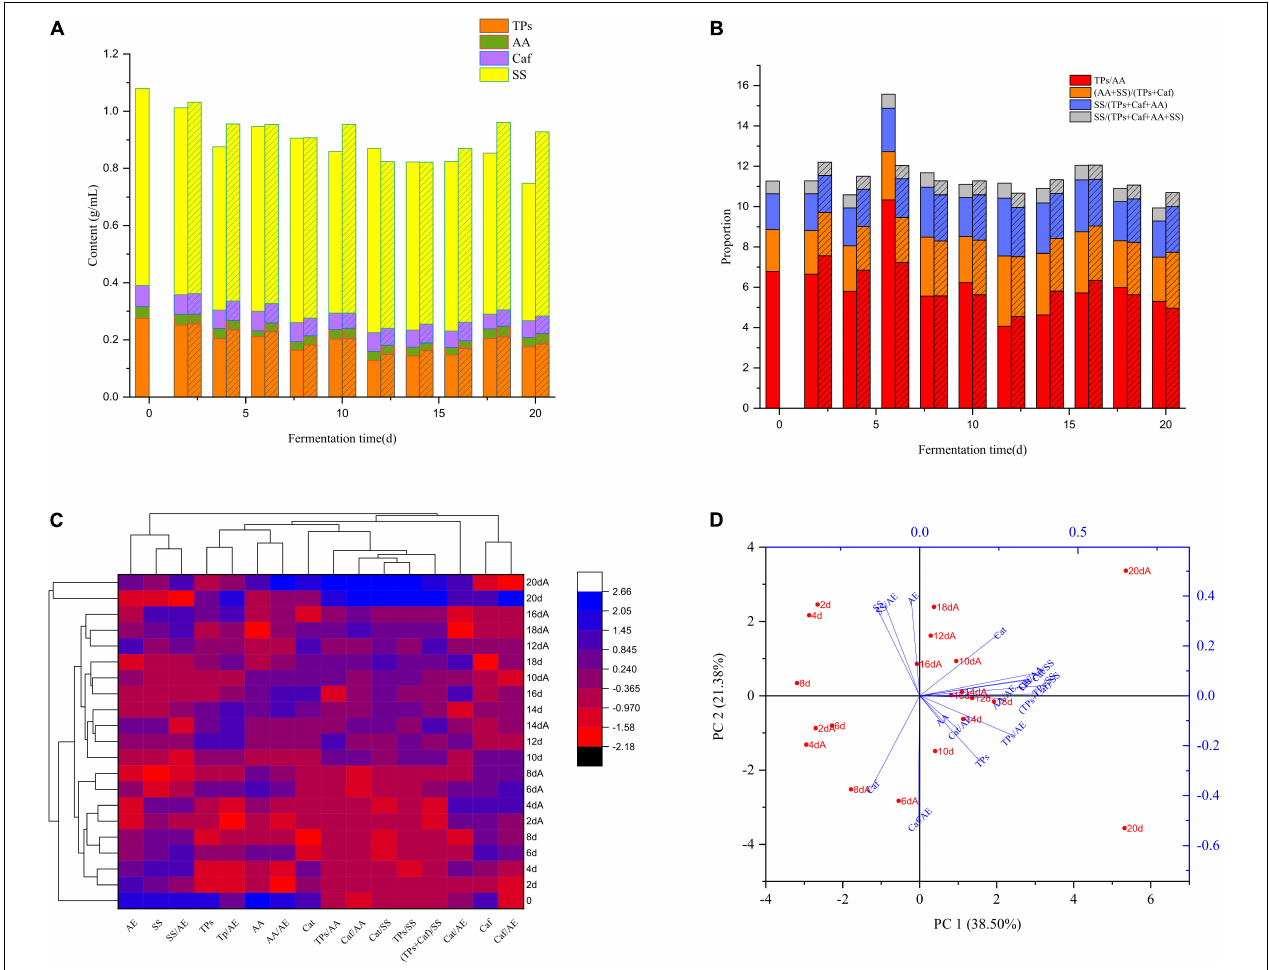
FIGURE 2 | Effect of Aspergillus niger M10 on the SSDT taste quality during fermentation. (A) Changes of primary taste-active components during submerged fermentation; column represents control and column filled with diagonal reflects M10. (B) Changes of the ratios of primary taste-active components during submerged fermentation; column reflects control and column filled with diagonal reflects M10. (C) Changes of sample taste-active components during solid-state fermentation; each row and column in the heatmap represents the samples at different fermentation times and a taste-active component, respectively; the red and blue colors denote their levels. The fermentation time marked with A represents AM10, while the unmarked represents the control. (D) PCA of samples undergoing solid-state fermentation based on the taste-active